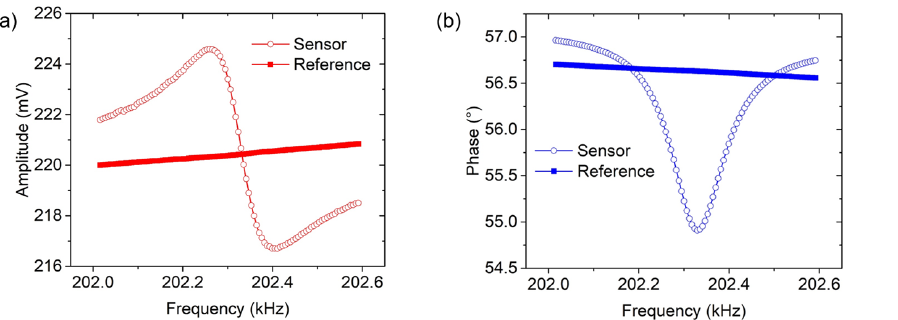
Figure 8. Measured sensor and reference signals: (a) amplitude response of asymmetric shape with a nearly constant reference, and (b) a reversed phase response with reference.